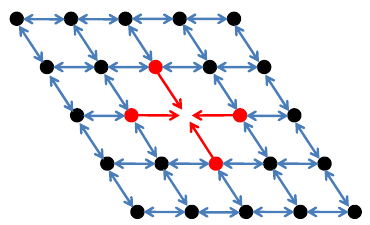
Figure 7: Principle of inferring missing PS from the local neigh- bourhood.